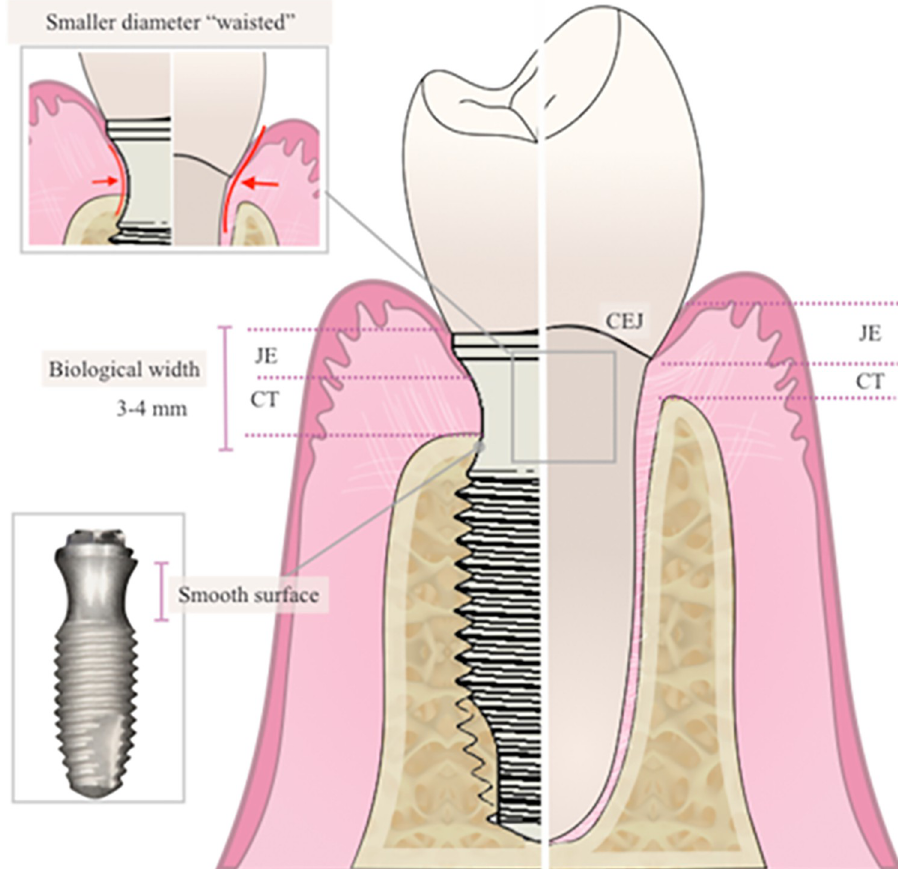
Fig 1. Comparison between the Collo implant and natural teeth